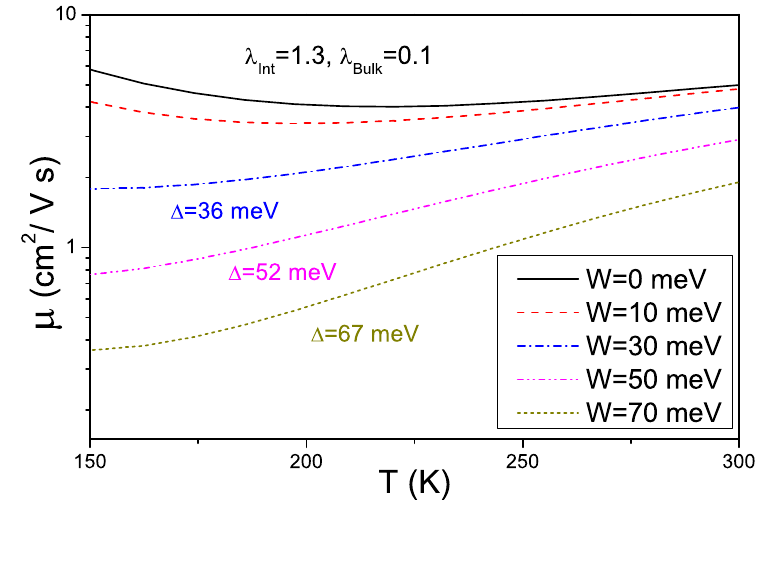
Figure 10. Mobility µ as a function of the temperature for different disorder strengths, W , at λ = 0 . 1 and λ = 1 . 3 . The quantity, ∆ , is the polaron activation Bulk Int